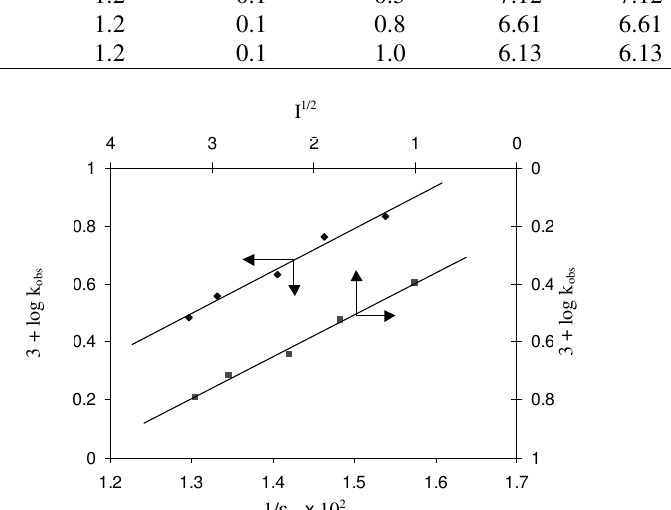
Figure 2. Effect of solvent polarity ( ε ) and ionic strength (I) on the oxidation of 4-hydroxy T coumarin by diperiodatonickelate(IV) in aqueous alkaline medium at 25 0